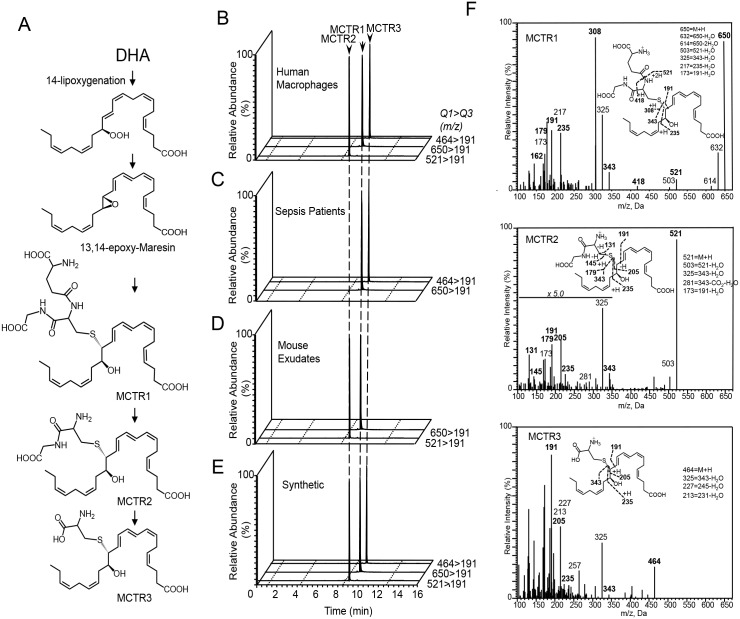
Endogenous MCTR from human macrophages, sepsis plasma and mouse infectious exudates match synthetic materials.(A) MCTR biosynthetic pathway. (B-D) Endogenous MCTR were obtained from (B) human macrophages (1x107 cells/ml) incubated with E. coli (5x108 CFU/ml; 30min, 37°C, PBS+/+; n = 3 macrophage preparations). (C) Sepsis plasma (n = 3 patients) (D) mice were inoculated with 105 CFU/mouse E. coli and exudates collected after 24h (n = 3 mice). Products were extracted using C18 SPE and profiled using lipid mediator metabololipidomics. (E) Synthetic material. Results representative of 3 separate determinations. (F) MS-MS spectra for synthetic MCTR1, MCTR2 and MCTR3. Results are representative of d = 3.